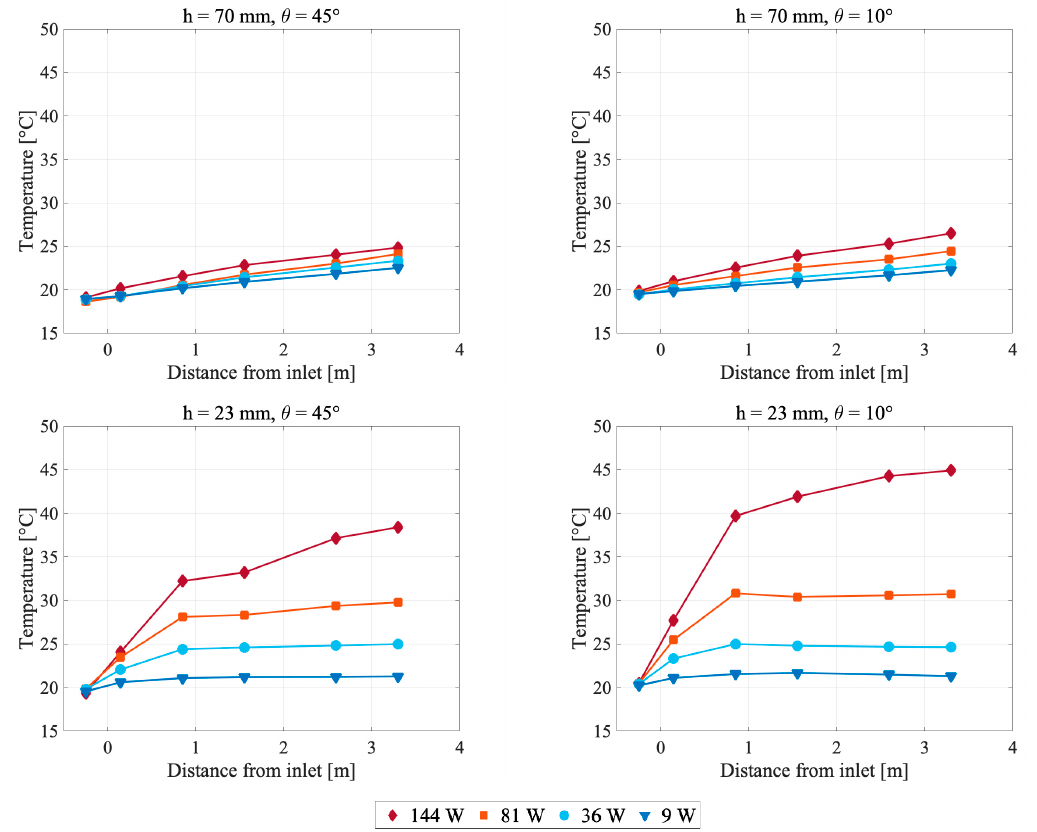
Figure 5. Temperatures ( ◦ C) in the cavity air as a function of distance (m) from the cavity inlet. Each plot represents a given air cavity height (h) and roof inclination ( θ